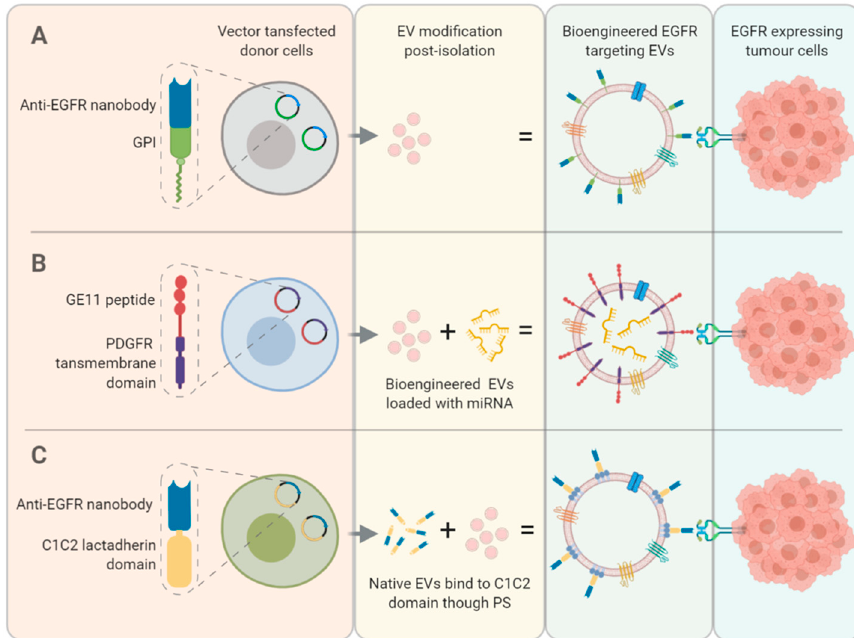
Figure 3. Bio-engineering strategies to enhance EV targeting to EGFR expressed on tumour cells include: ( A ) transfection of a donor cell with a plasmid containing anti-EGFR nanobody and glycosylphosphatidylinositol (GPI) elements and ( B ) a plasmid containing GE11 peptide and platelet derived growth factor receptor (PDGF) elements which would subsequently be packaged into the donor cell derived EVs. ( C ) Native EVs bind to the C1C2 domain of a recombinant protein containing an anti-EGFR nanobody through phospholipid phosphatidylserine (PS).